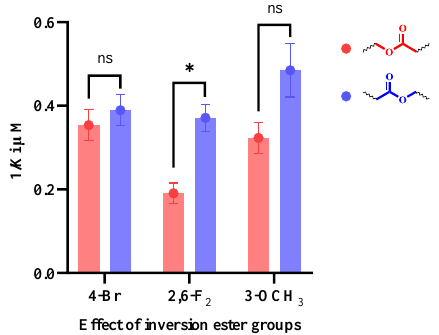
Figure 3. The effect of inversion ester groups on binding affinity with ApisOBP9; Data represent the mean ± standard deviation. Significance calculated using T test (* p < 0.05; ns p > 0.05).